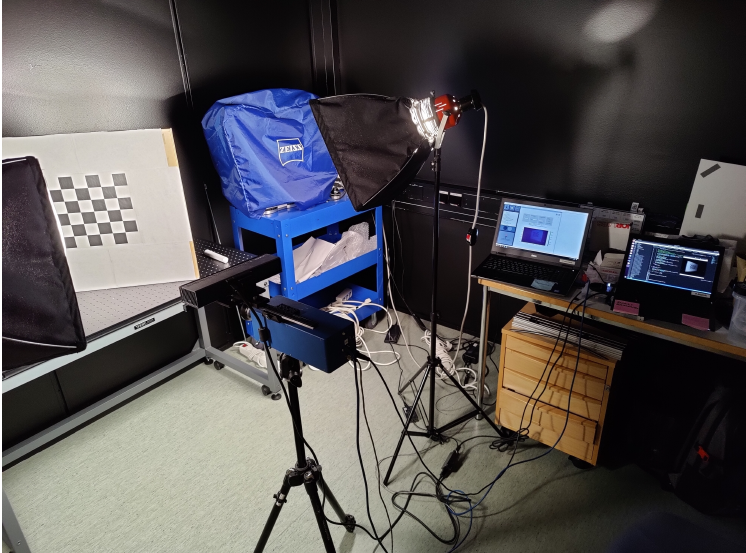
Figure 5. The experimental calibration setup with the hyperspectral camera, Kinect, halogen diffusers, and realignable checkerboard calibration